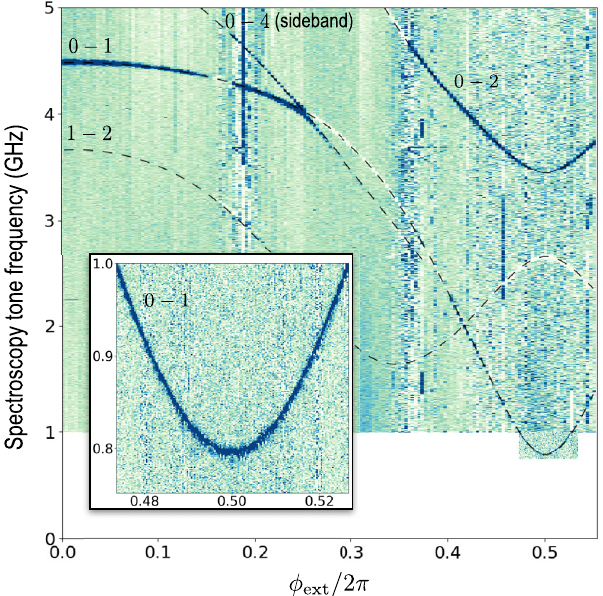
FIG. 2. Two-tone spectroscopy transmission signal (arbitrary units) as a function of the spectroscopy frequency and flux through the loop for device A . The contrast is optimized piece- wise to maximize the visibility of the resonances. Lines indicate a fit to the spectrum of the Hamiltonian (1). The extra resonance line crossing (not anticrossing) the qubit transition 0 – 1 is the red sideband of the 0 – 4 transition and the readout at 7.5